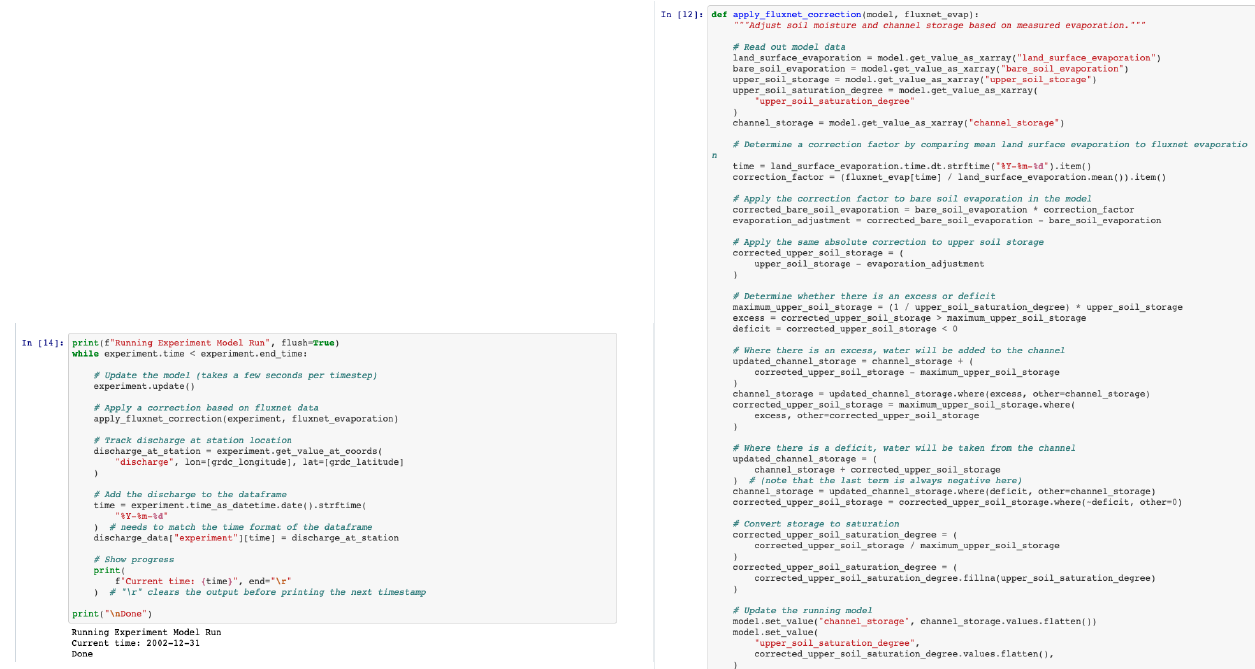
Figure 12. The code used to interfere with the state of PCR-GlobWB 2.0 during runtime. This code is available through Hut et al. (2021) (https://doi.org/10.5281/zenodo.5543899). Each time step the function apply_fluxnet_correction() is called. The right-hand side of this figure shows the code of that function. The model.get_value_as_xarray() called at the start of the function extracts information on the state from the model. The model.set_value() called at the end of the function updates the state with the newly calculated information. This example shows that numerical hydrologists can interact and experiment with the state of a hydrological model without having to interact with the code of the model. In this way a clear separation between model and experiment is